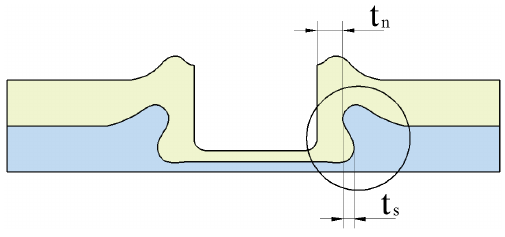
Figure 2. Main geometrical parameters of the improved clinched joint.